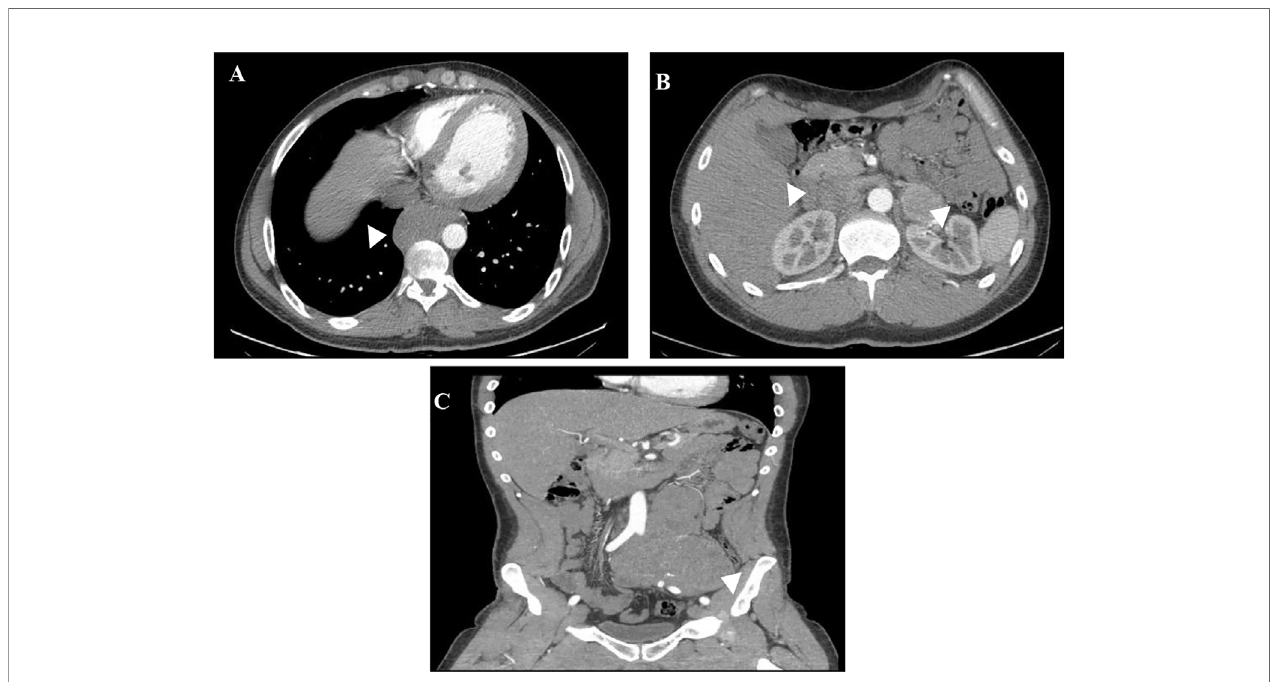
FIGURE 1 | WB-CT scan at diagnosis of patient 1. Posterior mediastinal mass paravertebral to T9-T11 vertebral bodies (A) , bilateral adrenal lesions (B) and periaortic and peri-common iliac artery lesion with an extensive encasement of this vessel (C) .